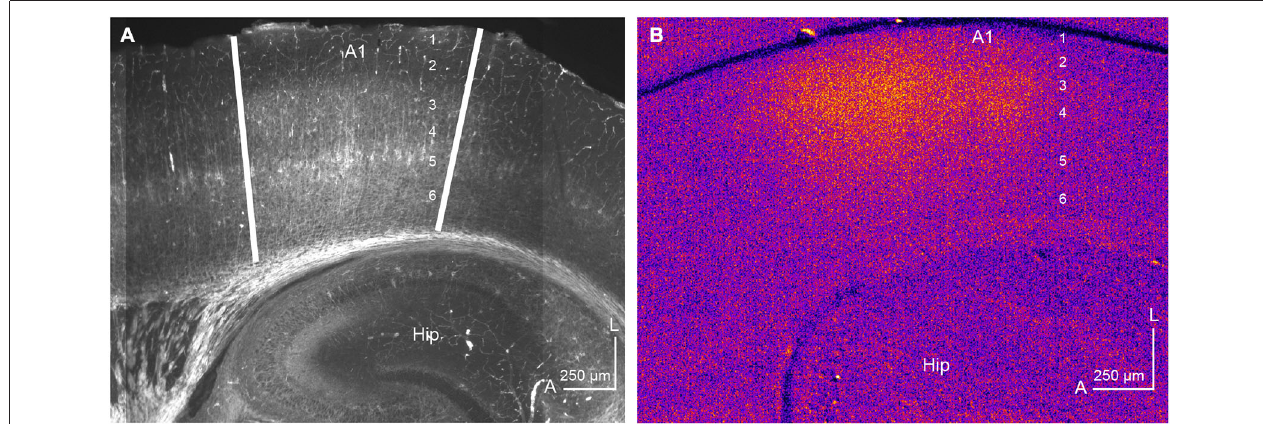
semi-horizontal thalamocortical section (500 µ m) of mouse A1. A rectangle positive current (200 µ A) was injected for one second in the MGBv using a concentric bipolar microelectrode. Hot colors show activated areas, corresponding to A1. The numbers in A1 indicate cortical layers. Hip: hippocampus, A: anterior, L: lateral. Modified from Lee and Imaizumi